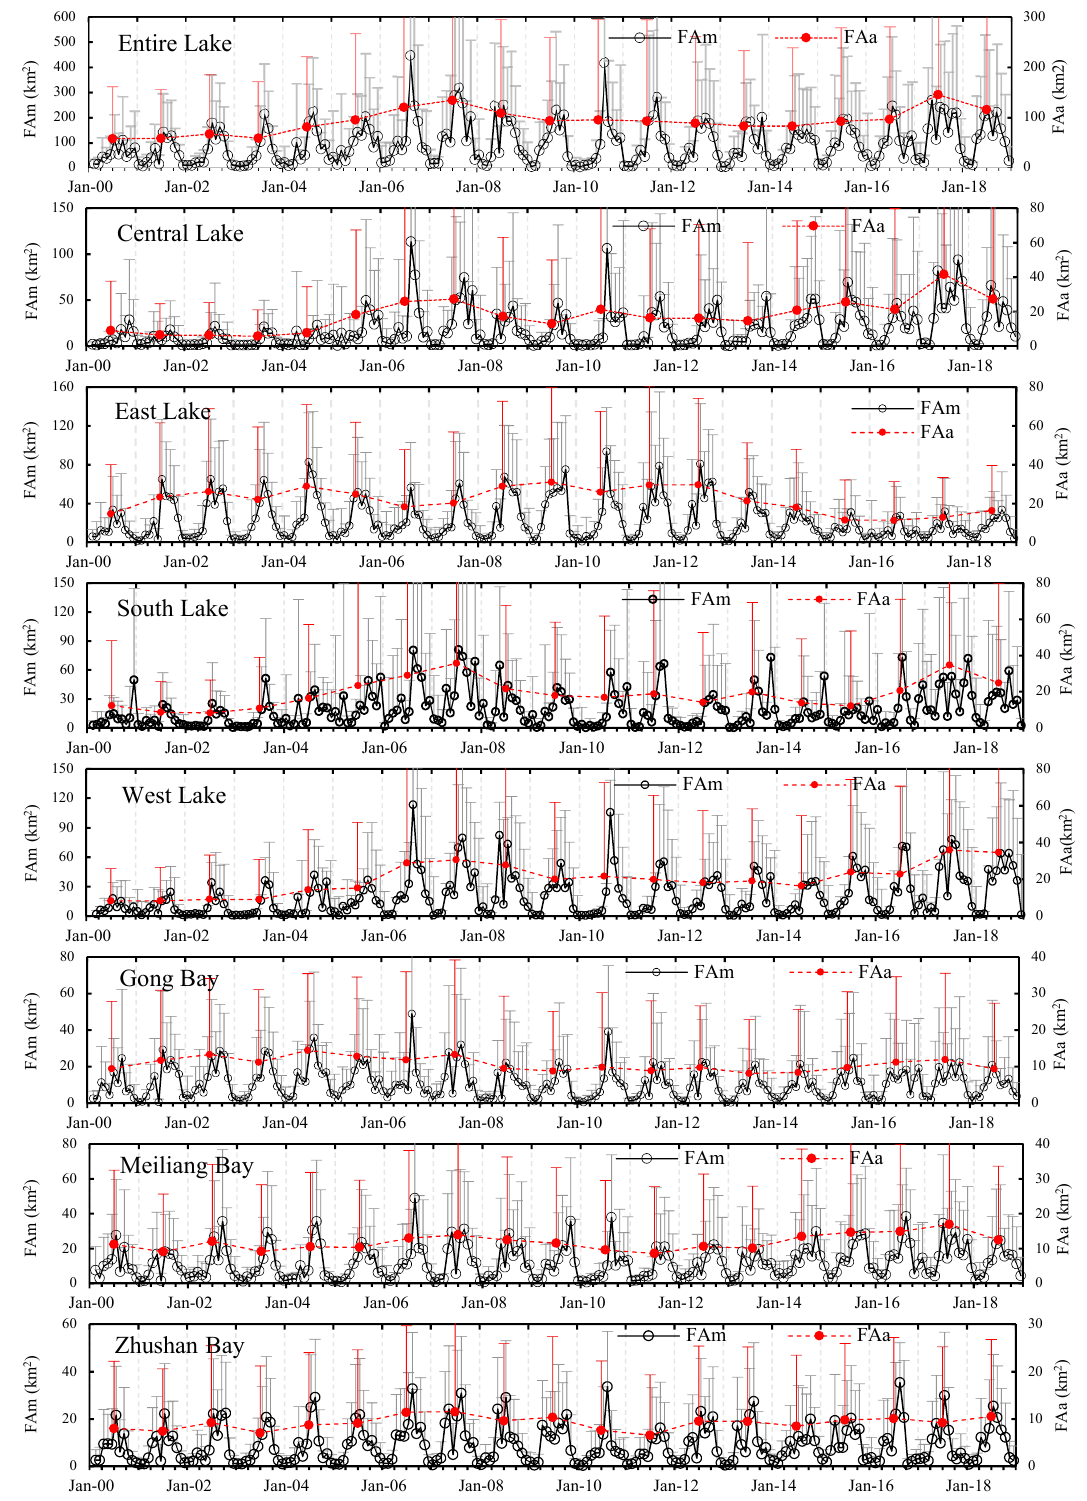
Figure 9. Floating cyanobacteria monthly (FA m ) and annual (FA a ) mean coverage area for the entire lake (excluding East Bay) and each segment. Black circles and red dots represent FA m and FA a , respectively; gray upper shadow and red upper shadow represent positive deviation of FA m and FA a ,